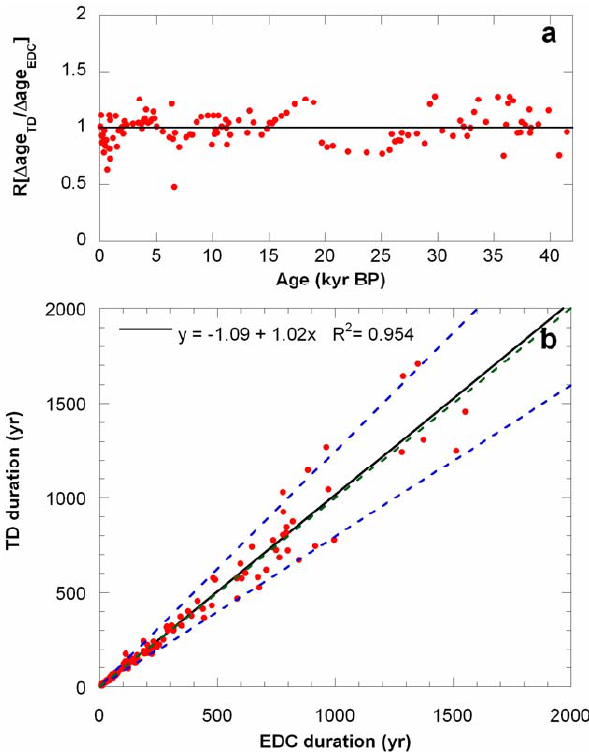
Fig. 7. The top panel (a) shows the ratio Age diff. EDC /Age diff. TALDICE ( R ) between couples of volcanic events dated using EDC dating by Lemieux-Dudon et al. (2010) and the TALDICE-1 model by Buiron et al. (2011). The bottom panel (b) shows the durations between two consecutive synchronisation markers in TD compared to durations in EDC. The bold black line is the linear regression line; the bold dashed green line is the 1:1 curve. Dashed blue lines represent the 1:0.8 and 0.8:1 lines.